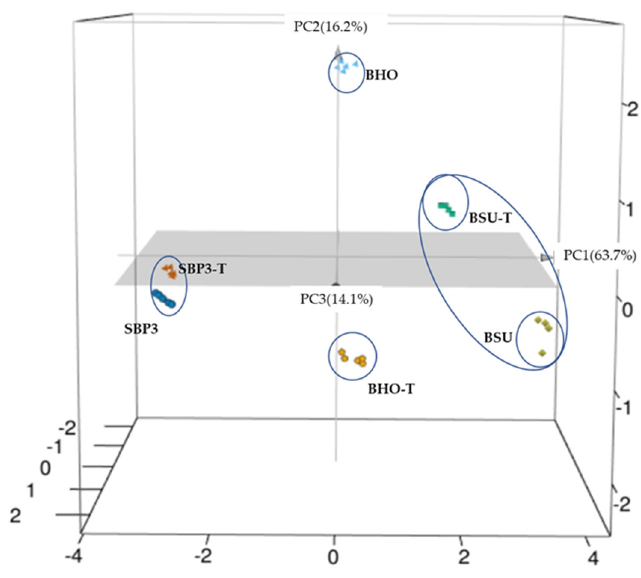
Figure 6. PCA plot of untreated and wet-heat-treated (-T) spores from Bacillus horneckiae SBP3 (SBP3), Bacillus horneckiae DSM 23495 T (BHO) and Bacillus subtilis 168 (BSU).